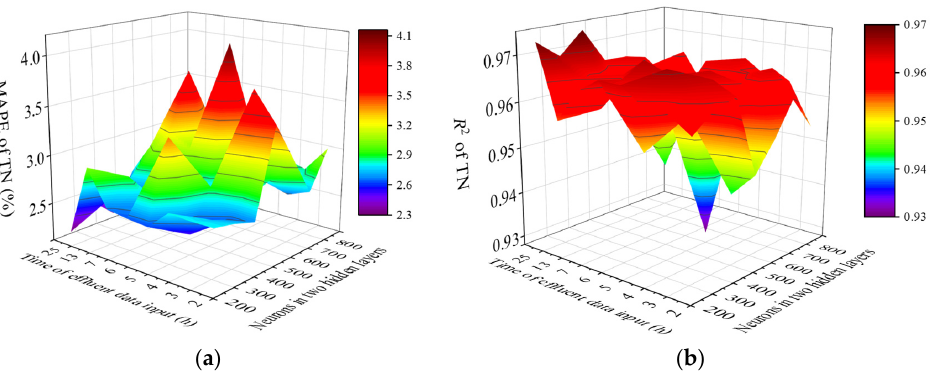
Figure 8. Change of IFFNN performance for TN with artificial neurons in the two hidden layers and time period of historical effluent data input: ( a ) MAPE and ( b ) R 2 of test datasets.